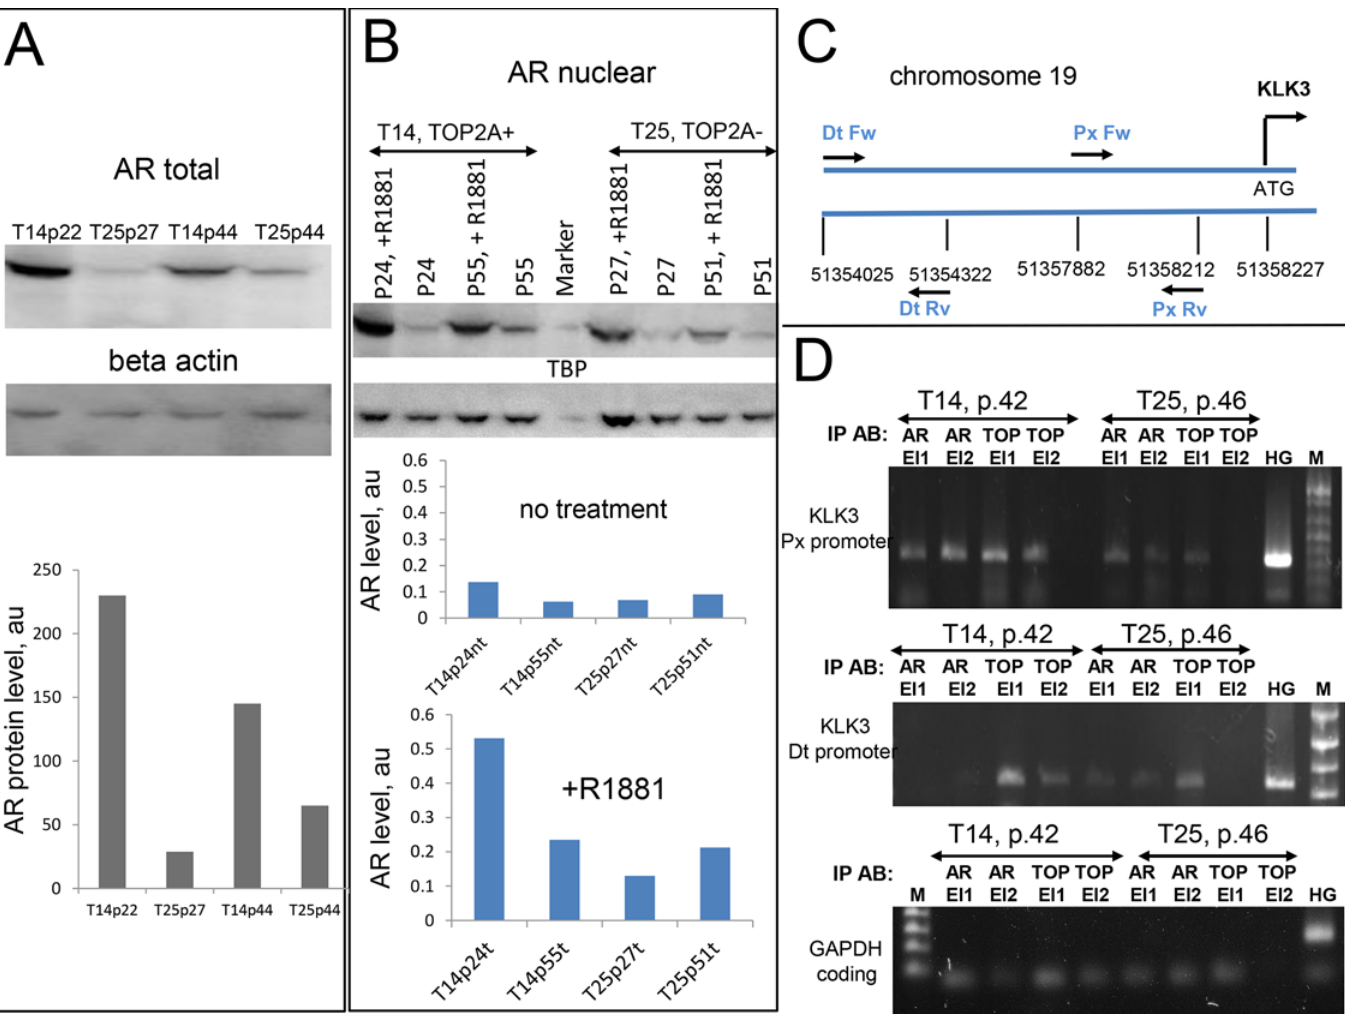
Fig 4. TOP2A protein is co-recruited to promoters of androgen responsive elements to stimulate gene expression. Western blot showing total level of AR in TOP2A clones of different passages (as indicated), top panel. Quantification of AR expression normalized to beta actin level, bottom panel. B) Western blot showing induction of AR level (top) upon treatment of TOP2A clones.with 5 nM of R1881. Corresponding quantification of TOP2A levels normalized to TBP loading control is shown (bottom); nt is non-treated, t is treated; cell passages are as indicated. C) Schematic showing promoter area for KLK3 (PSA) gene used in CHIP assay. DtFw and DtRv depict positions of forward and reverse primers respectively for distal promoter region; PxFw and PxRv -positions for forward and reverse primers of proximal promoter. D) CHIP analysis of TOP2A clones stimulated with 5 nM of R1881 for 3 hours. Enrichment of AR and TOP2A at distal and proximal promoter regions of KLK3 gene (top and middle panels) and their absence at coding region of GAPDH gene (bottom panel) are shown. M is DNA size marker, HG-is human genomic DNA used as a positive control for PCR amplification, El1 and El2 are consecutive elution fractions (buffers are described in